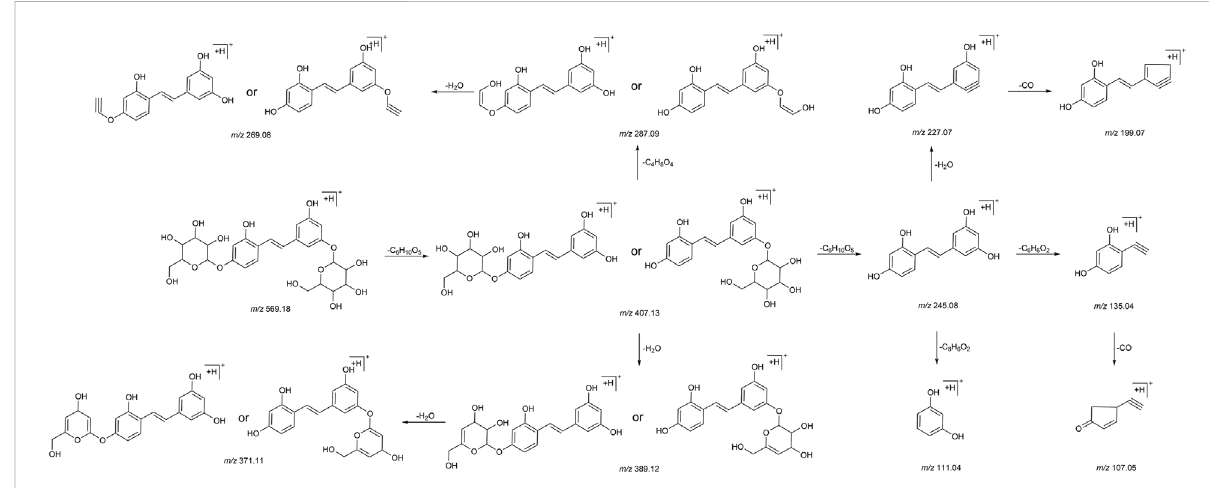
FIGURE 4 The mass fragmentation behavior of Mulberroside A in positive ion mode.